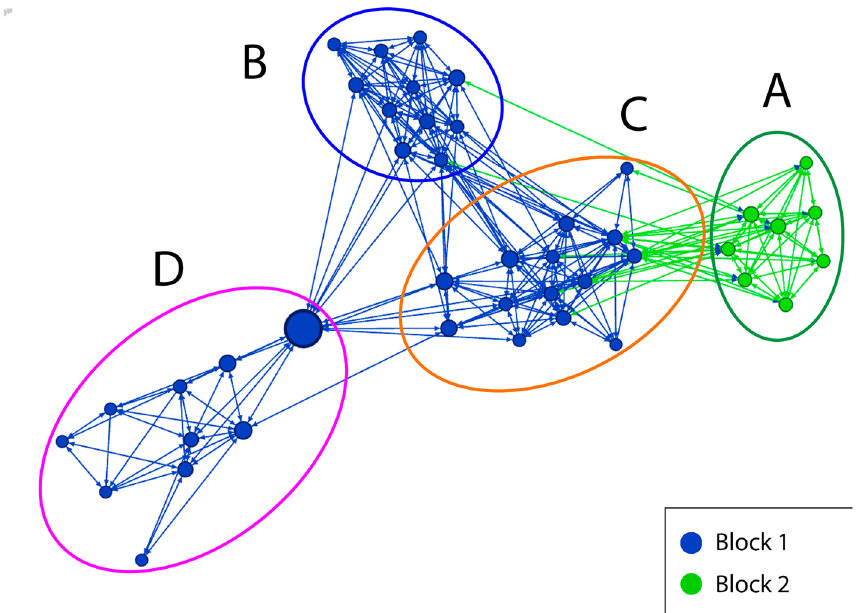
Figure 2. Subgroups Girvan–Newmann Residence block result [created with Gephi 0.92 (https:// gephi.